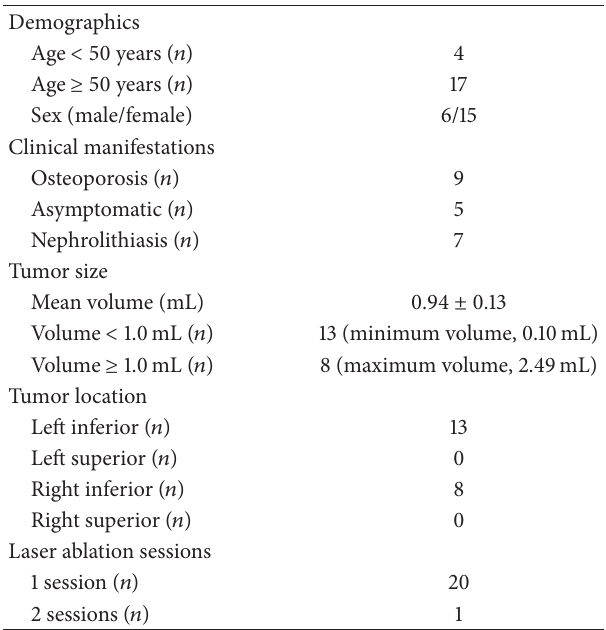
Table 1: Demographic and clinical characteristics of the 21 patients enrolled in the